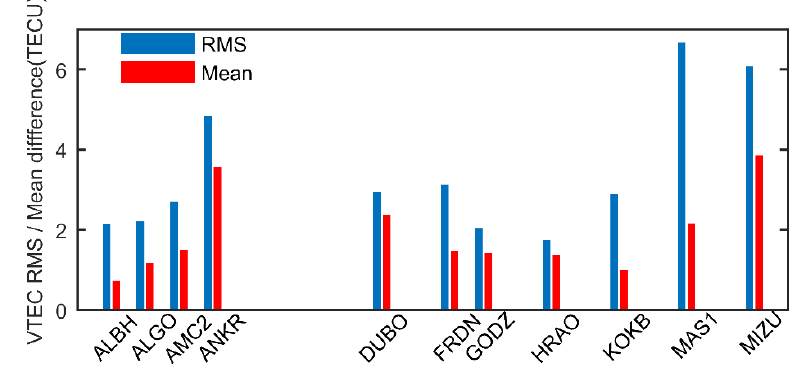
Figure 11. Mean difference and RMS with respect to interpolated CODE GIM over 20 sample stations during the disturbed period. The horizontal axis shows the name of stations. The missed stations are not labeled.